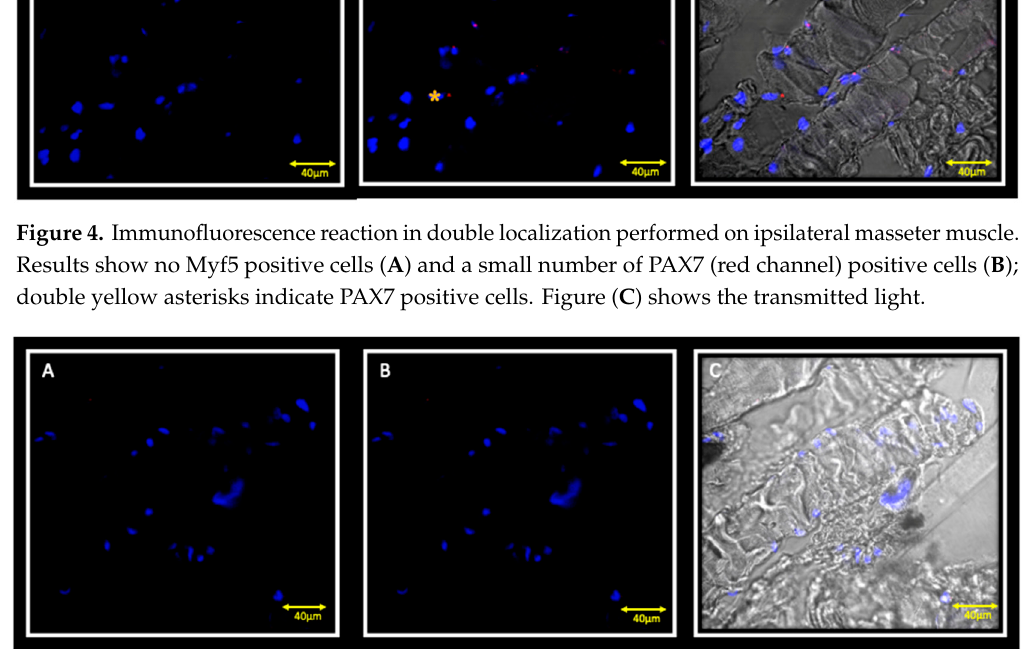
Figure 5. Immunofluorescence reaction in double localization performed on the ipsilateral masseter muscle showing cells that are negative both for Myf5 ( A ) and MyoD ( B ). Nuclei are stained with DAPI (blue channel). The ( C ) pictures show the transmitted light.